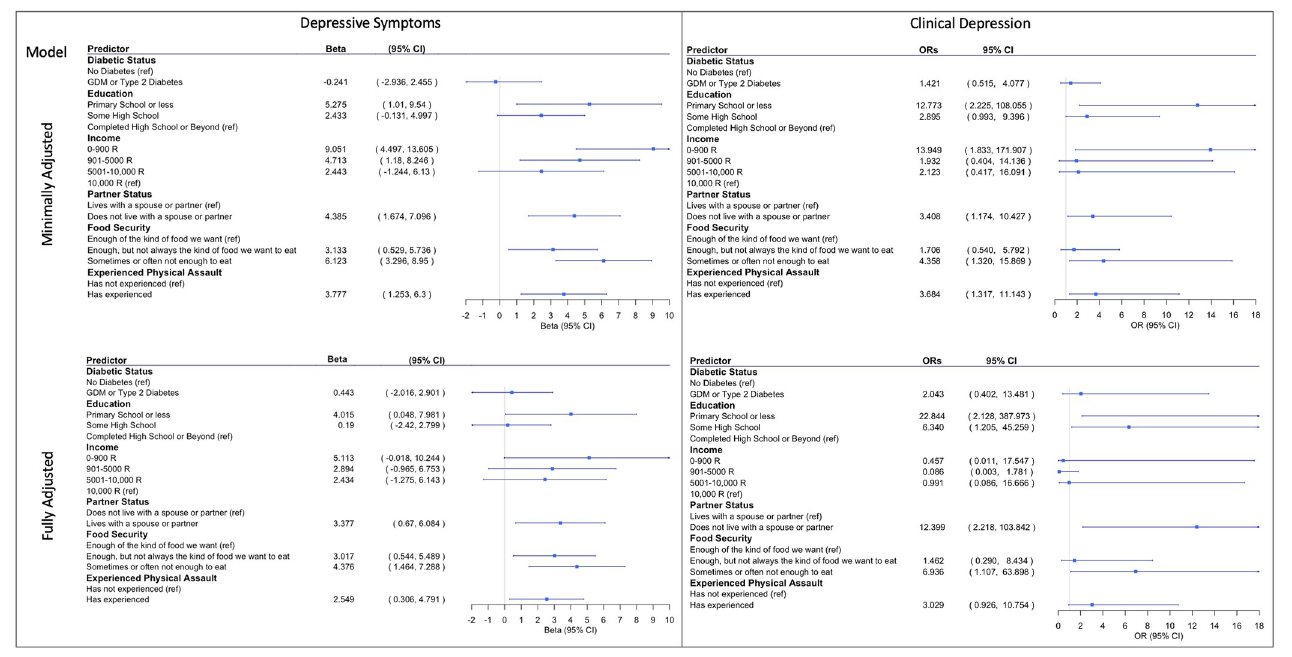
Fig 1. Betas and 95% CI for correlates of depressive symptoms (left) and odds ratios and 95% CI for correlates of clinical depression (EPDS > = 13) (right). Minimally adjusted model was adjusted for maternal age. Fully adjusted model was adjusted for maternal age as well as the other maternal experiences. Maternal physical assault and income were analyzed in separate